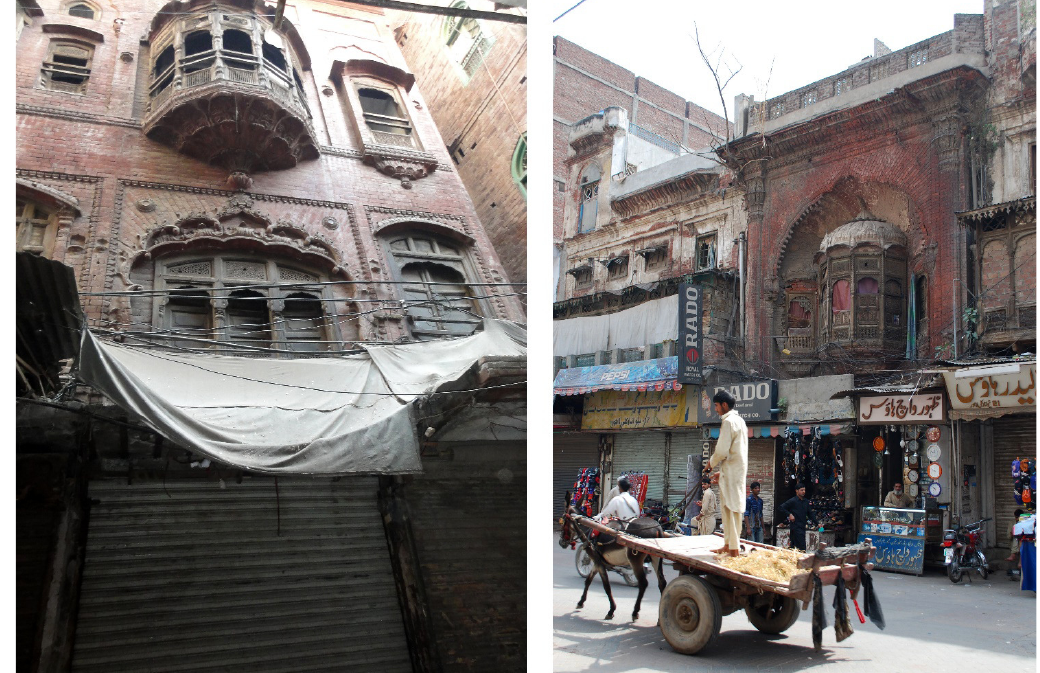
Figure 4. Carved wooden windows and jharokas . Photos by Helena Cermeño (2014, left, Laal Haveli) and Katja Mielke (2012,